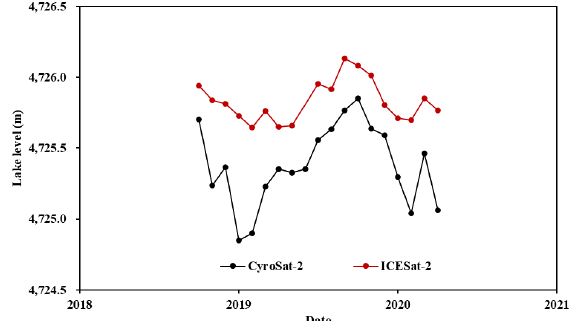
Figure 7 . Intra-annual changes of lake level from 2016 to